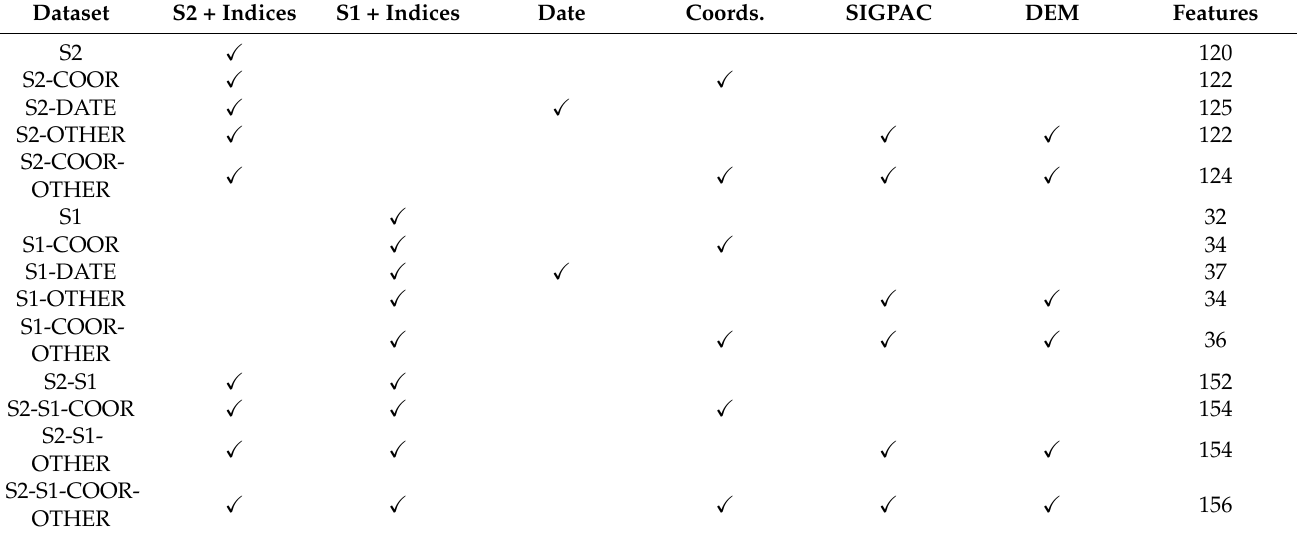
Table 3. Features of the generated